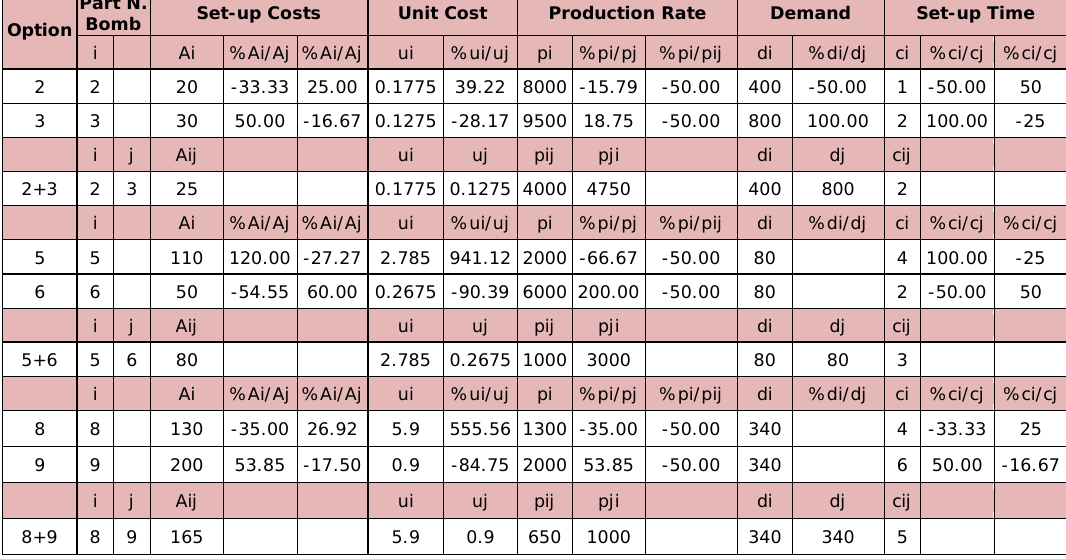
Table 3. “The modified Bomberger Dataset”.